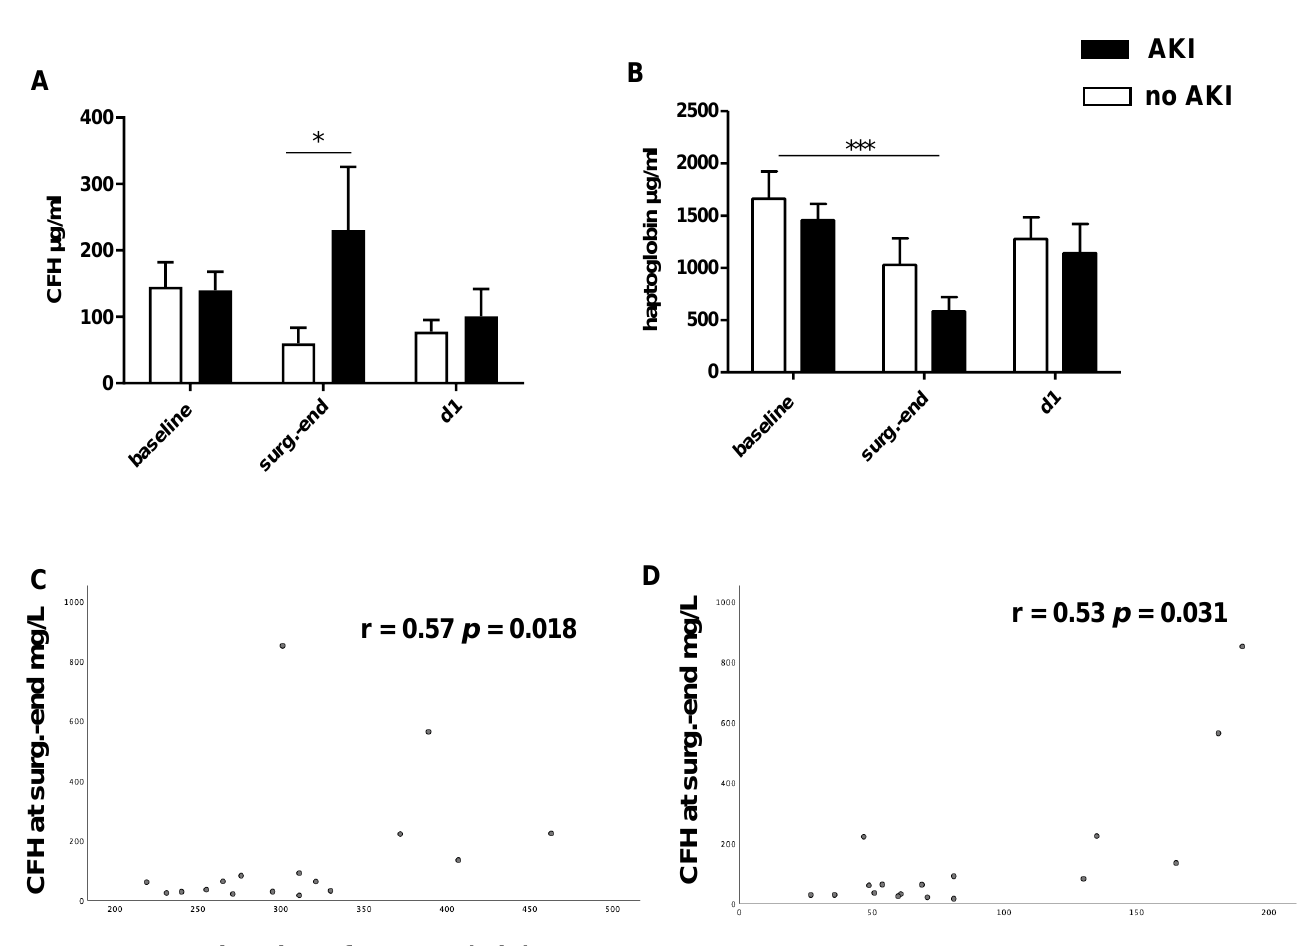
Figure 1. Plasma-free hemoglobin (CFH, ( A )) and haptoglobin levels ( B ) in lung transplant (LuTx) patients with AKI (black bar) or without AKI (white bar). CFH was significantly higher at the end of surgery in LuTx patients with subsequent AKI ( A ). In parallel, a marked decline in plasma haptoglobin levels was found at the end of LuTx ( B ). CFH levels at the end of surgery (surg.-end) significantly correlated with duration of surgery ( C ) and serum creatinine 48 h after LuTx ( D ). Spearman’s r and p -values are shown. * p < 0.05, *** p < 0.001.